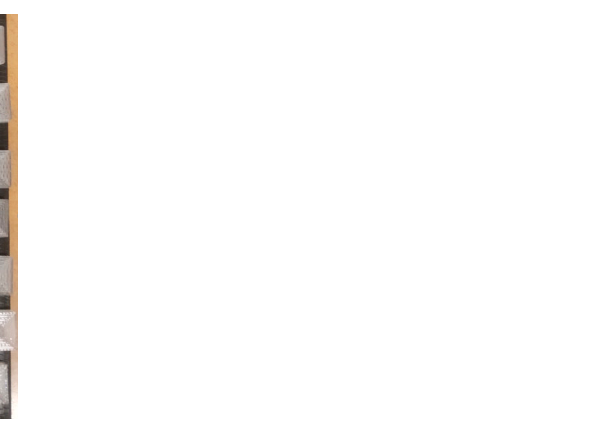
Figure 7. Failure modes of the specimens following tensile testing for a crosshead speed range of 1–1000 mm/min.